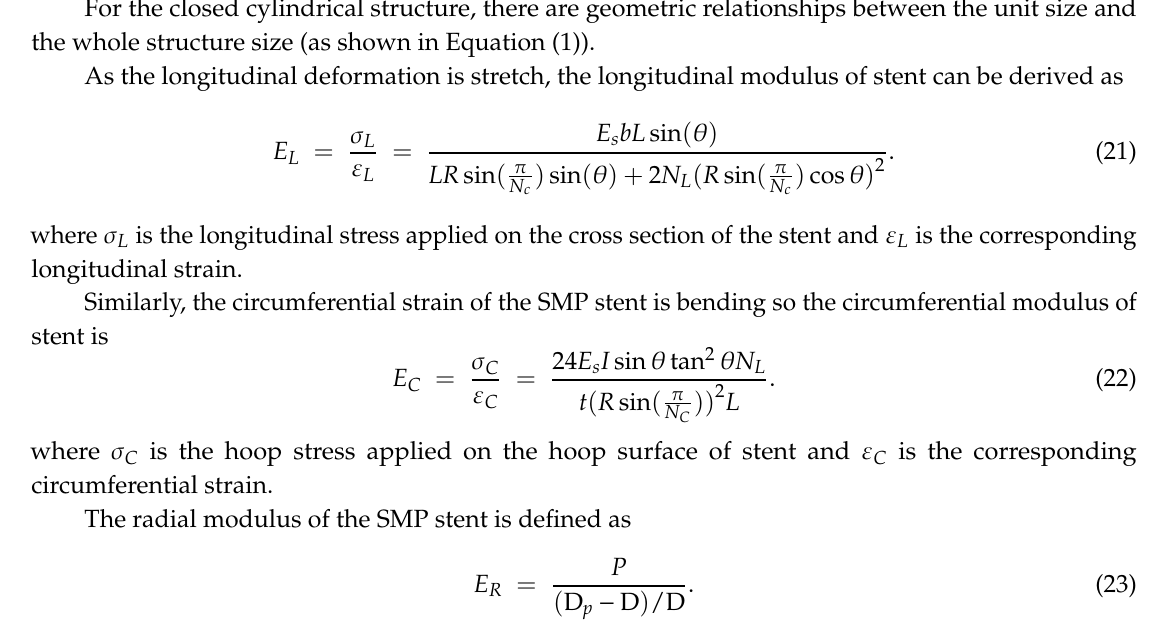
h θ l ; ( b ) Poisson ratios with different l .